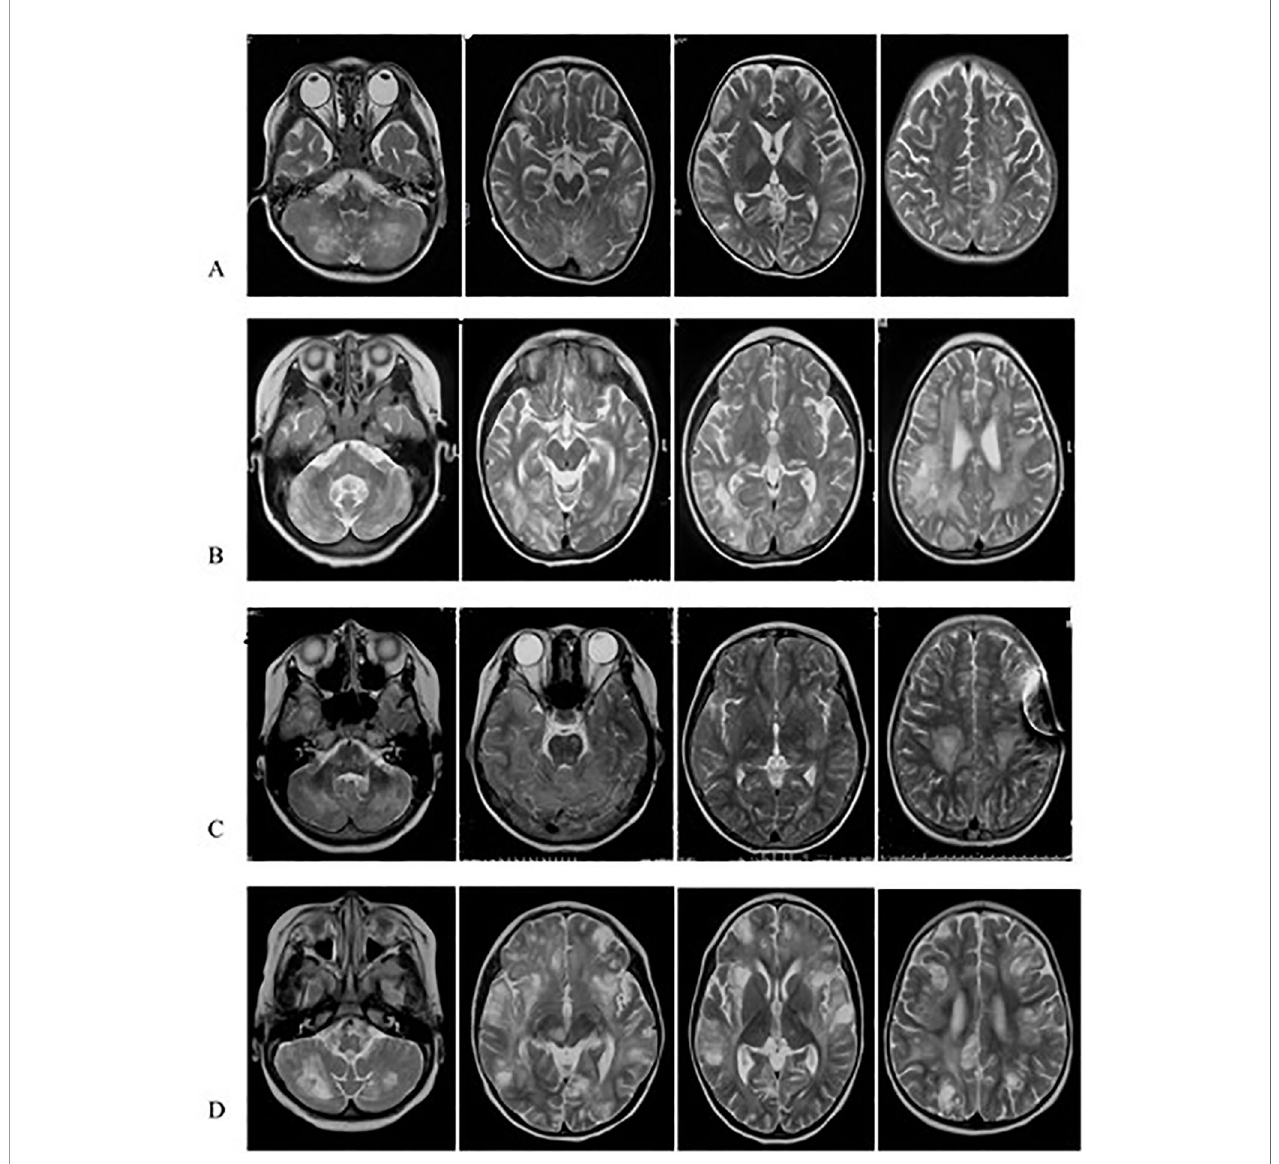
FIGURE 1 | TR-MRIs of Case1 (A) , Case2 (B) , Case3 (C) and Case4 (D) . The brain T2-MRIs revealed numerous irregular shape hypersignal areas involving cerebral hemispheres, cerebellar hemisphere, basal ganglia, mostly located in the conticomedullary junction and deep white